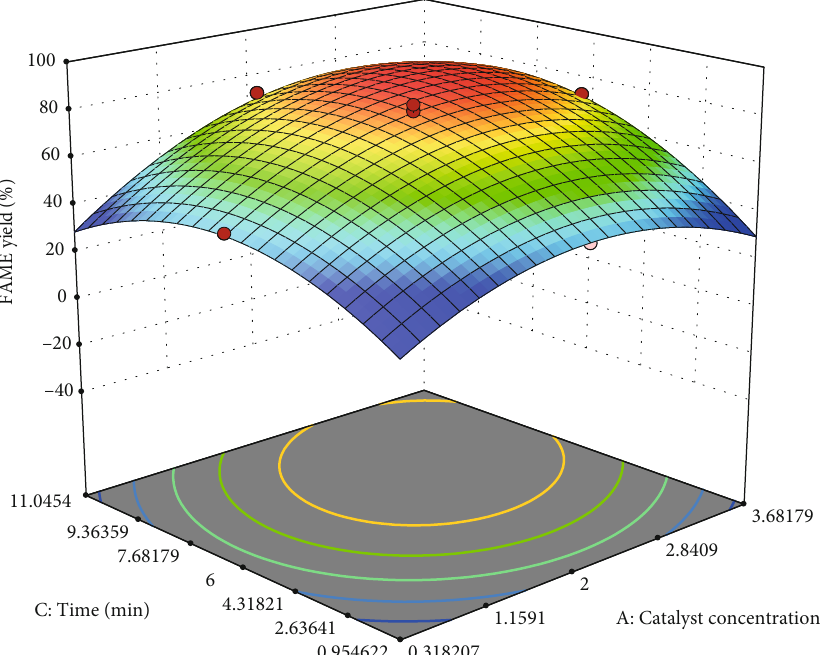
Figure 4: RSM plot: e ff ect of catalyst concentration ( H